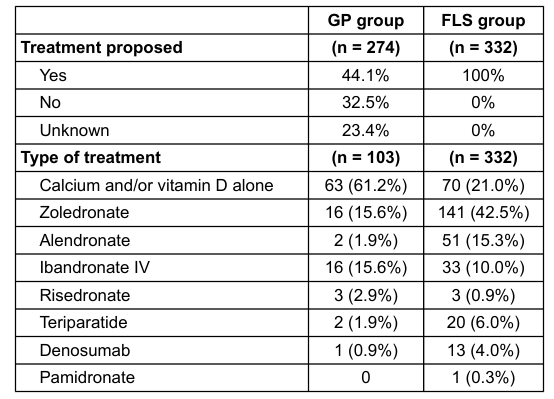
FLS = Fracture Liaison Service; GP = general practitioner Table 4: New fractures.